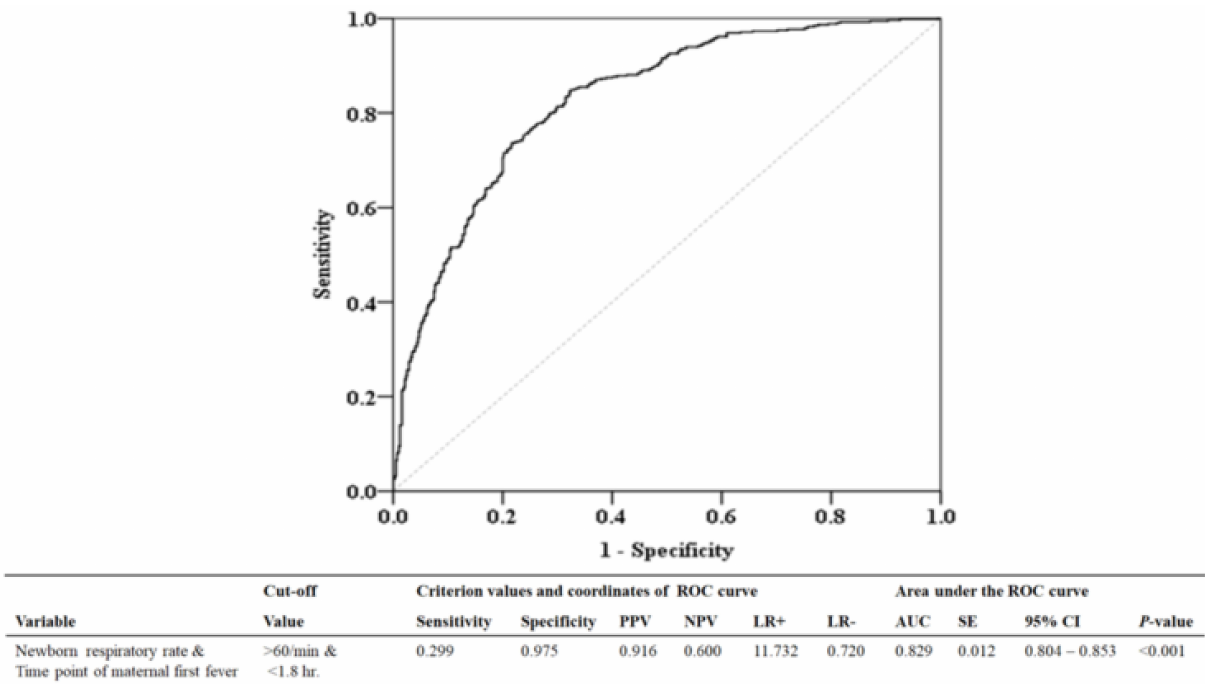
Figure 1. ROC curve to predict whether the baby has probable/proven sepsis based on the time point of the mother’s first fever (baby birth time as the origin) and infant’s respiratory rate. PPV, positive predictive value; NPV, negative predictive value; LR+, likelihood ratio for a positive test; − LR , likelihood ratio for a negative test; AUC, area under curve; SE, standard error; CI, confidence interval; hr, hour; min, minute.